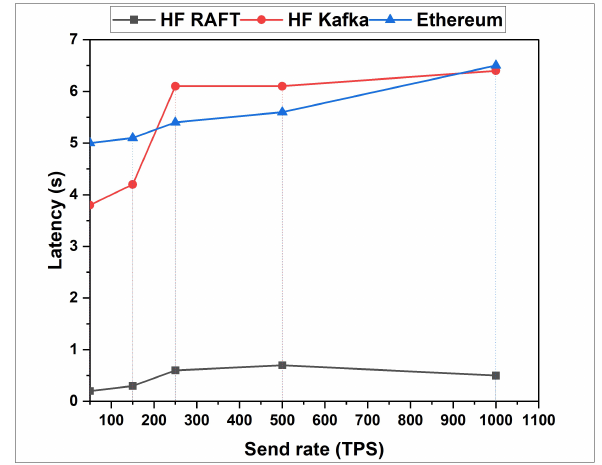
Figure 9. Latency for